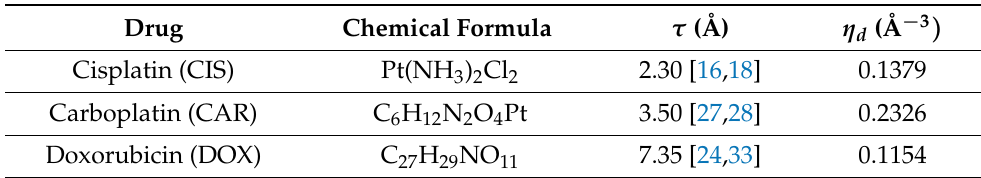
Table 2. Approximate numerical values for the mean volume density η d and radius τ of the sphere of each drug